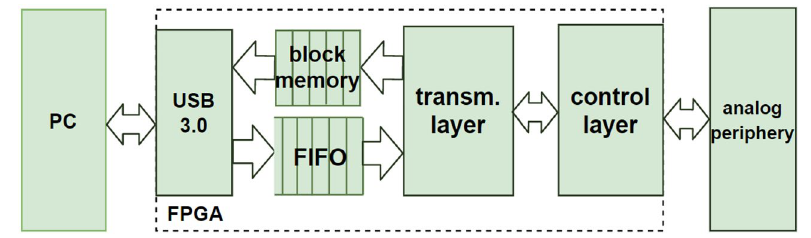
Figure 3. Digital interface hierarchy. The speed of internal data bus is 3.2 Gbps.